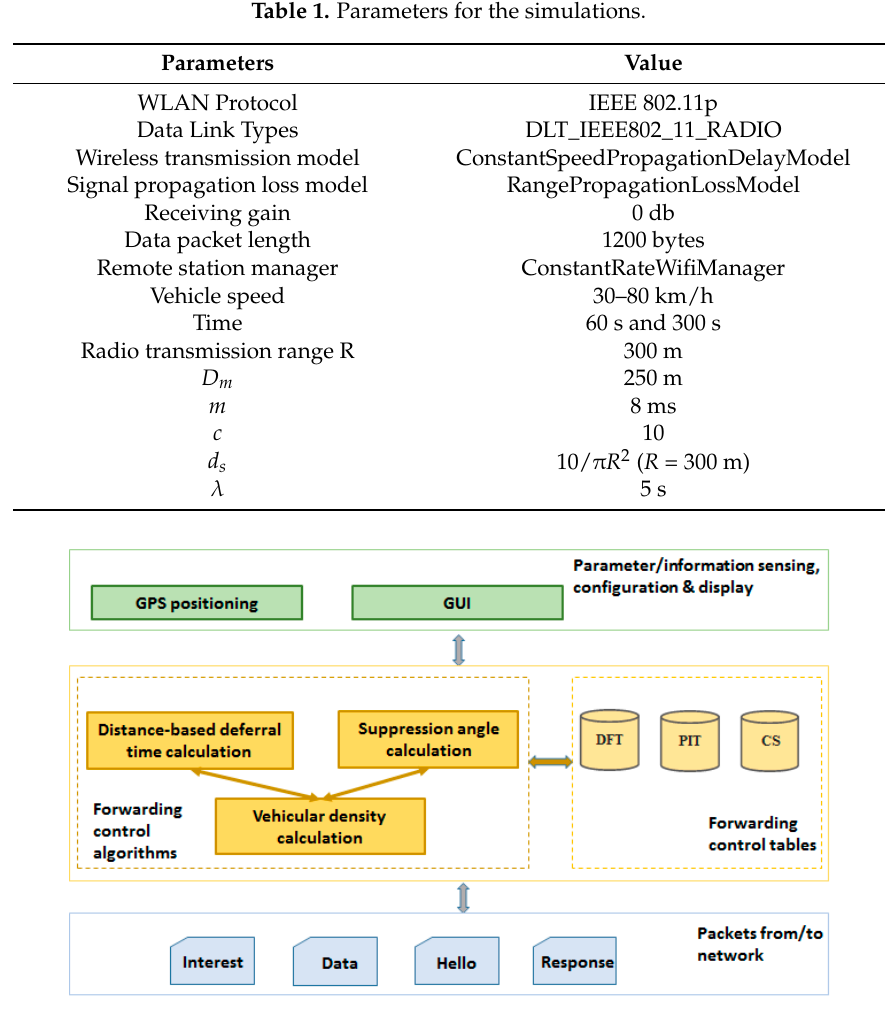
Figure 11. Data processing at vehicular nodes.